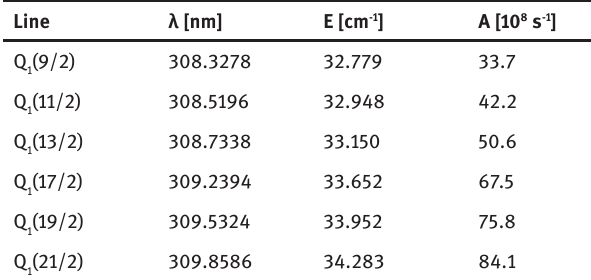
Table 3 : List and parameters of the selected OH spectral lines used for determining the rotational temperature using a Boltzmann plot.